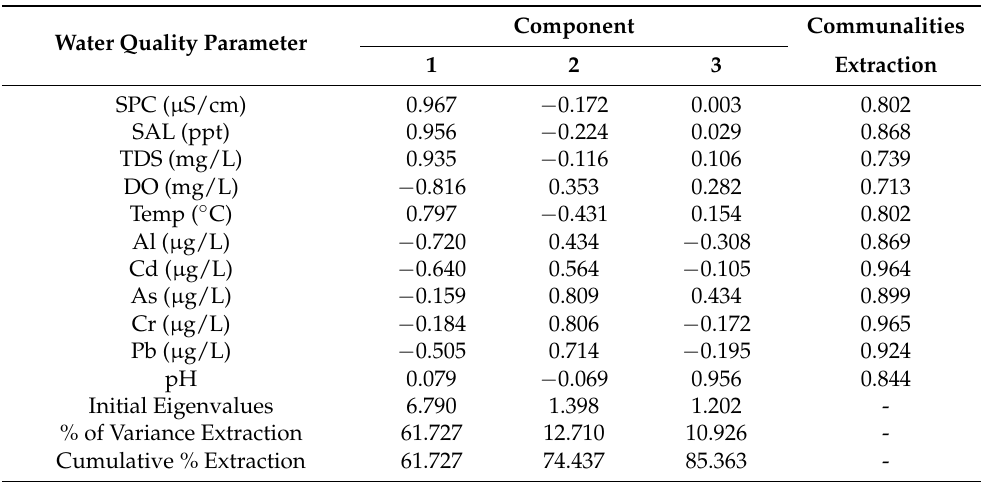
Table 6. Rotated component matrix for the water quality parameters. Water Quality